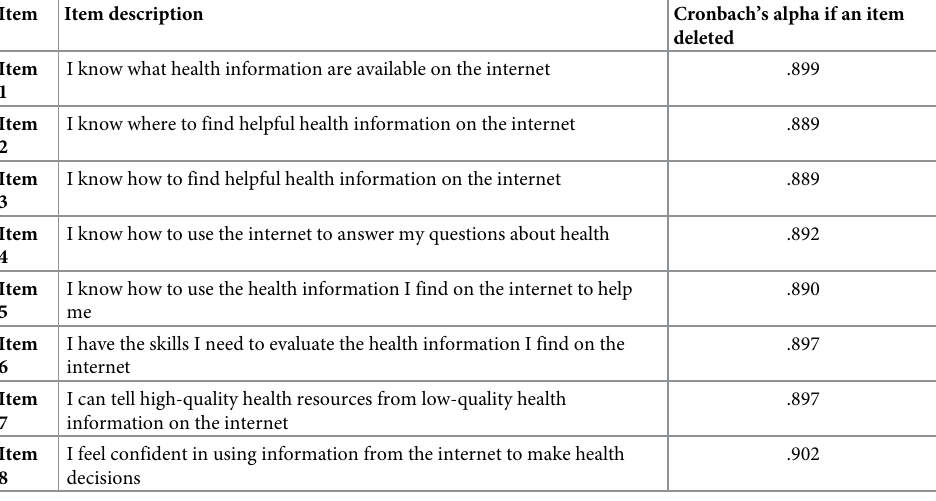
Table 3. Cronbach’s alpha if an item deleted (n = 268).